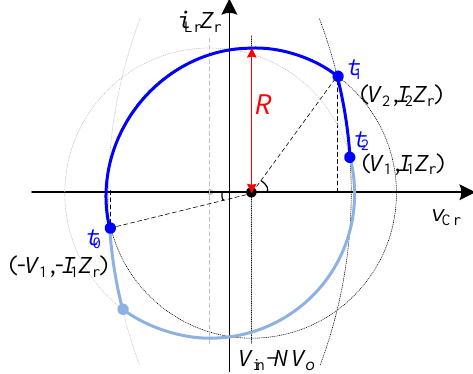
Figure 9. The state-trajectory of LLC resonant converter above resonant frequency in the ideal case. The magnetizing current increases linearly under the primary-side voltage of the transformer in the half cycle.